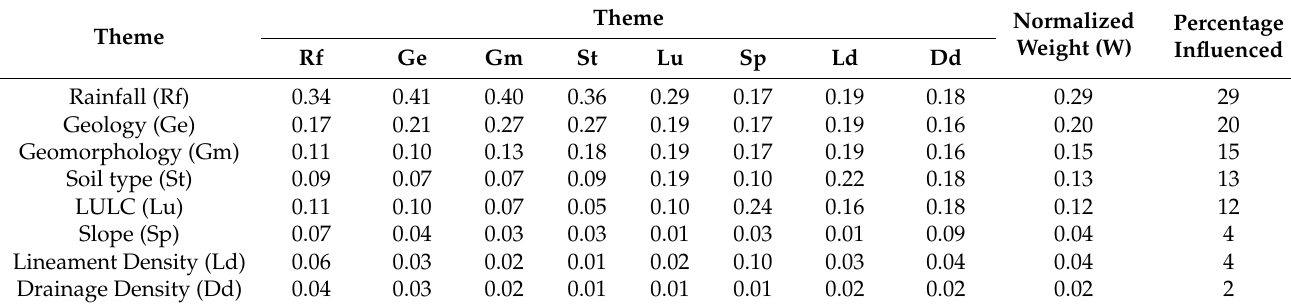
Table 4. Determining the normalized weights for thematic layers.